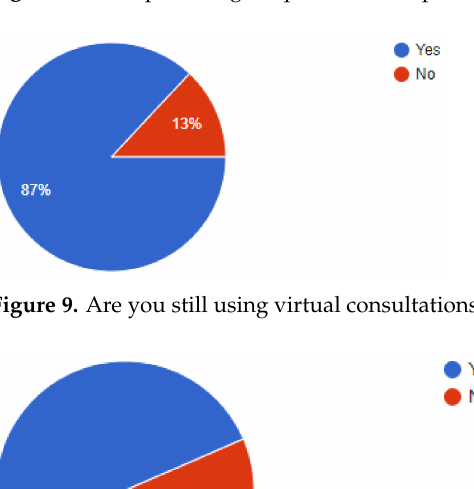
Figure 8. What percentage of patients have problems with existing schedules being cancelled?